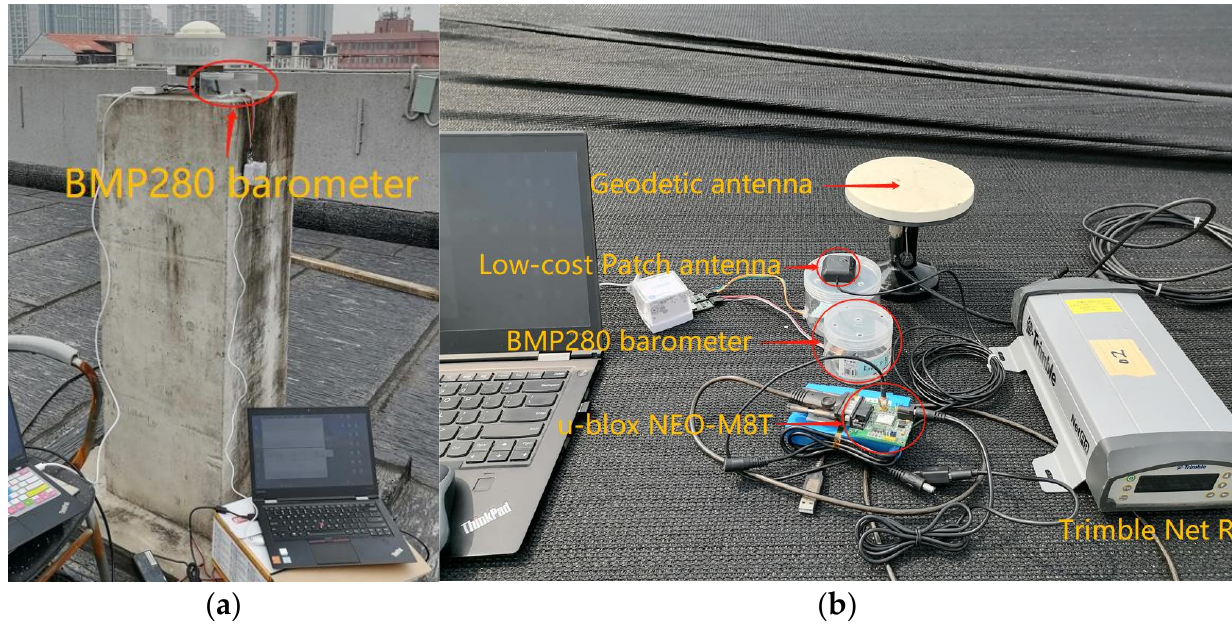
Figure 2. The hardware equipment in the DBA altitude accuracy evaluation and static positioning experiment: ( a ) reference station; ( b ) mobile station.